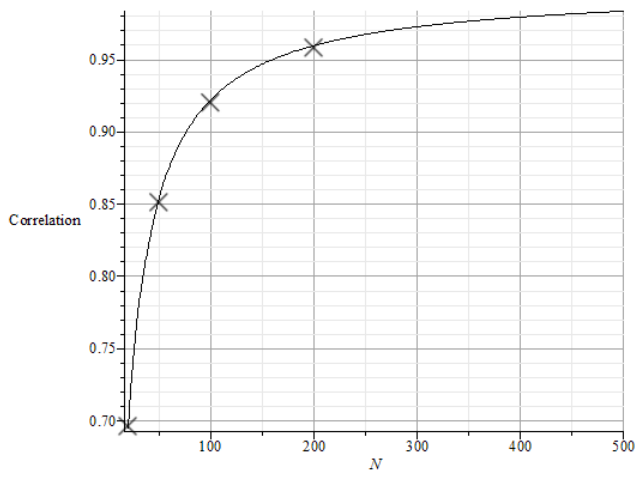
Figure 1: Plot of f ( x ) (see (8) ) using ρ estimated from 2000 aggregations of size 20, and true values of ρ N , N = 20, 50, 100, 200 , computed with the actual global Figure 1: f(x) (eqn(6) ) using ρ estimated from 2000 aggregations of size 20, and true values of ρ (N) , N = 20,50,100,200, computed with the actual global correlation.